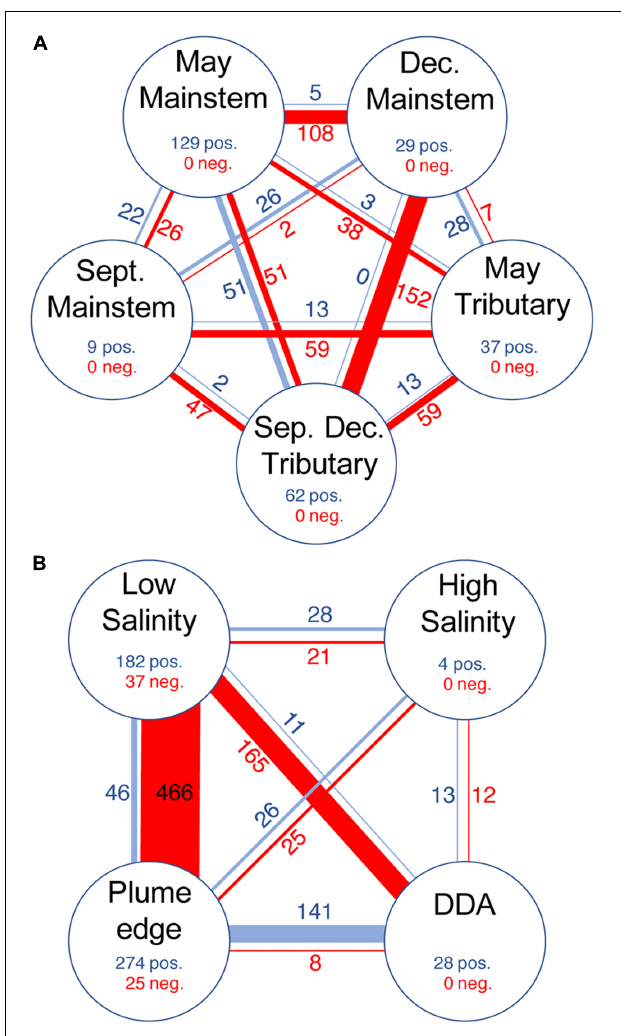
FIGURE 4 | The number of positive (blue) and negative (red) edges (i.e., correlations) for indicator taxa within co-occurrence networks for (A) all river samples, and (B) unfractionated and 0.2–2.0 µ m plume samples. Line thickness and numbers indicate the number of edges between node groups. Nodes and edges associated with non-indicator taxa are not